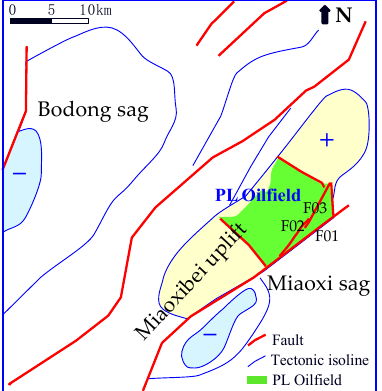
Figure 2. Structural location of PL oilfield.